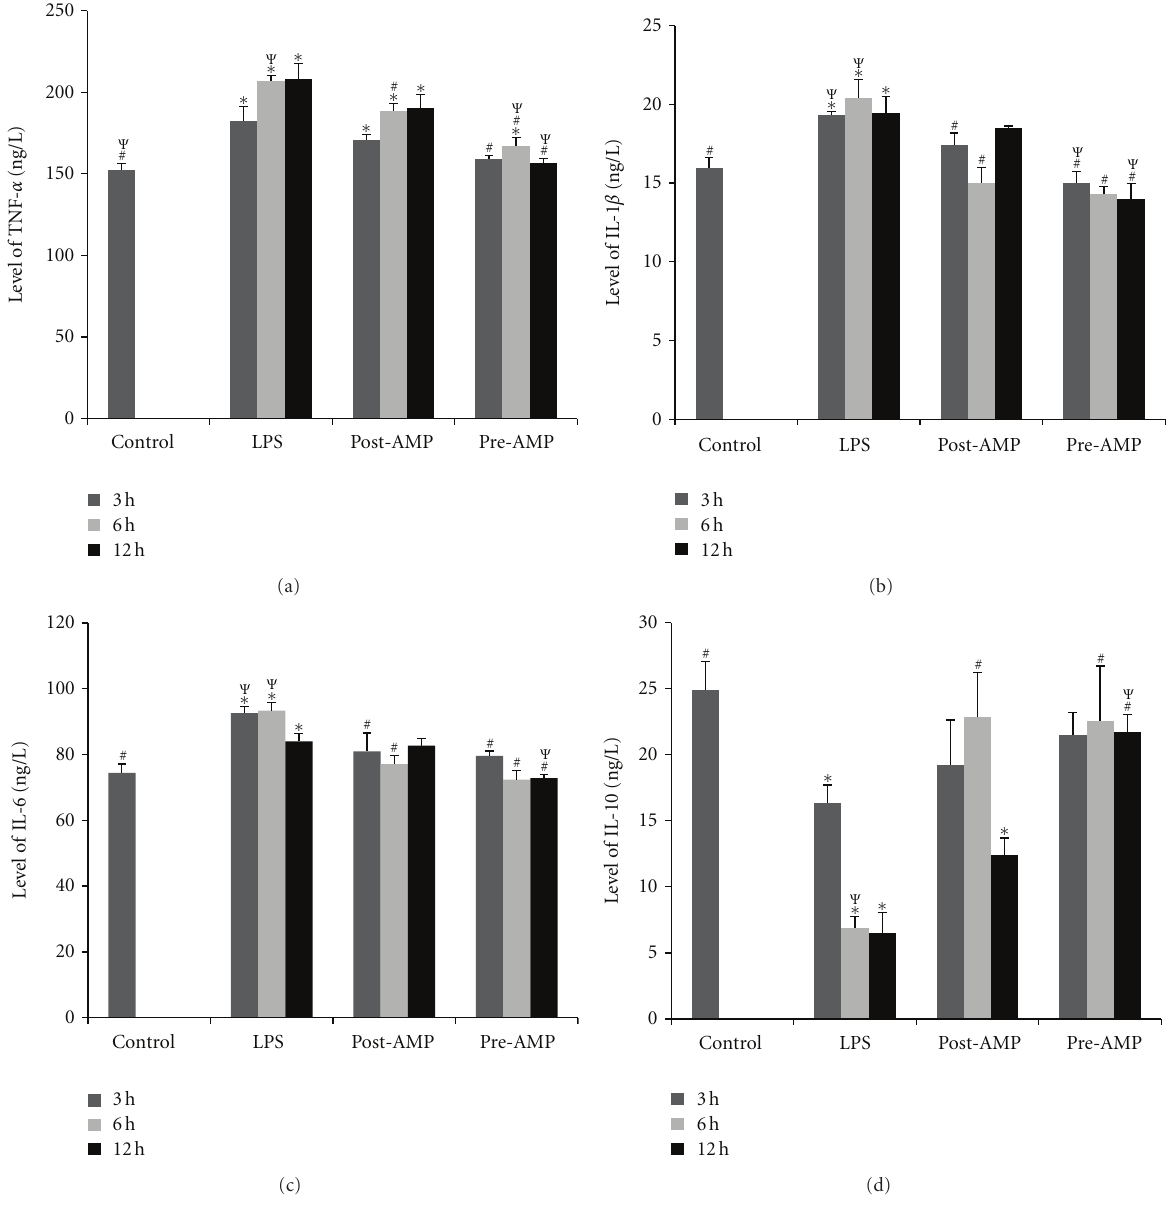
Figure 2: The plasma inflammatory factor levels.The plasma inflammatory factor levels in the rats were measured at 3 h, 6h, and 12h after LPS injection. (a) TNF- α ; (b) IL-1 β ; (c) IL-6; (d) IL-10. Control group: no treatment; LPS group: endotoxemia rat model induced by LPS; Posttreatment group: endotoxemia rat model treated with 5 (cid:2) -AMP. Pretreatment group: rats pretreated with 5 (cid:2) -AMP prior to LPS treatment. ∗ P < 0 . 05 versus control; # P < 0 . 05 versus LPS; Ψ P < 0 . 05 versus